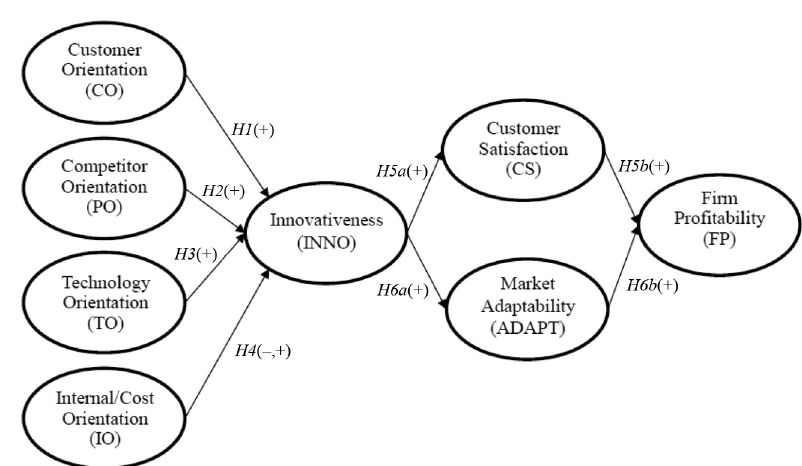
Figure 1. The research